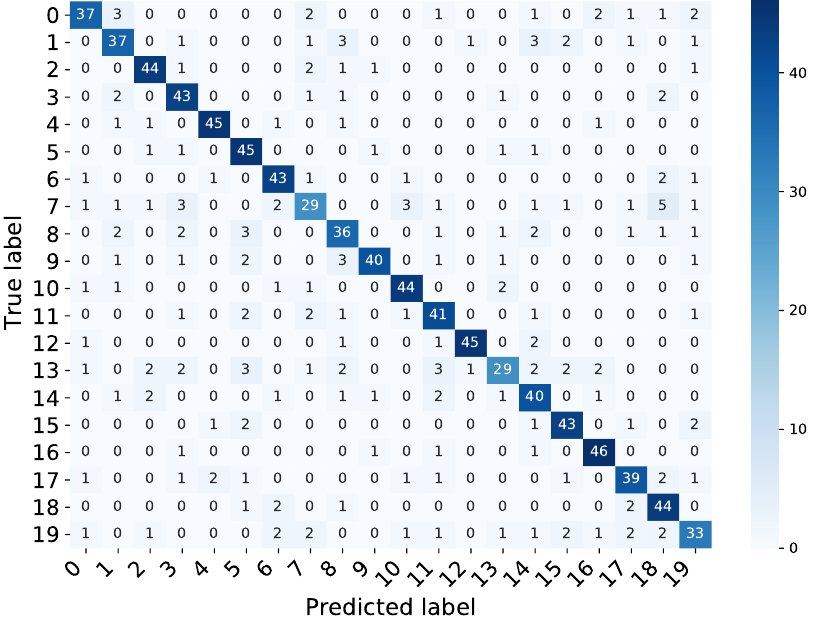
Figure 8. The confusion matrix for a classification run with n = 20 species displays that the miss- classifications are spread among several classes. This can result in an overestimation of the averaged AUC for multi-class